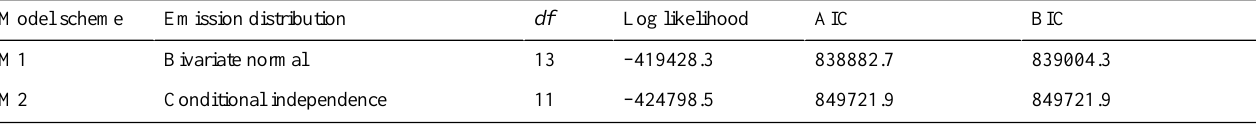
Table 1. Comparison of models fitted to heart rate and log(XSTEP+1) for EL02.